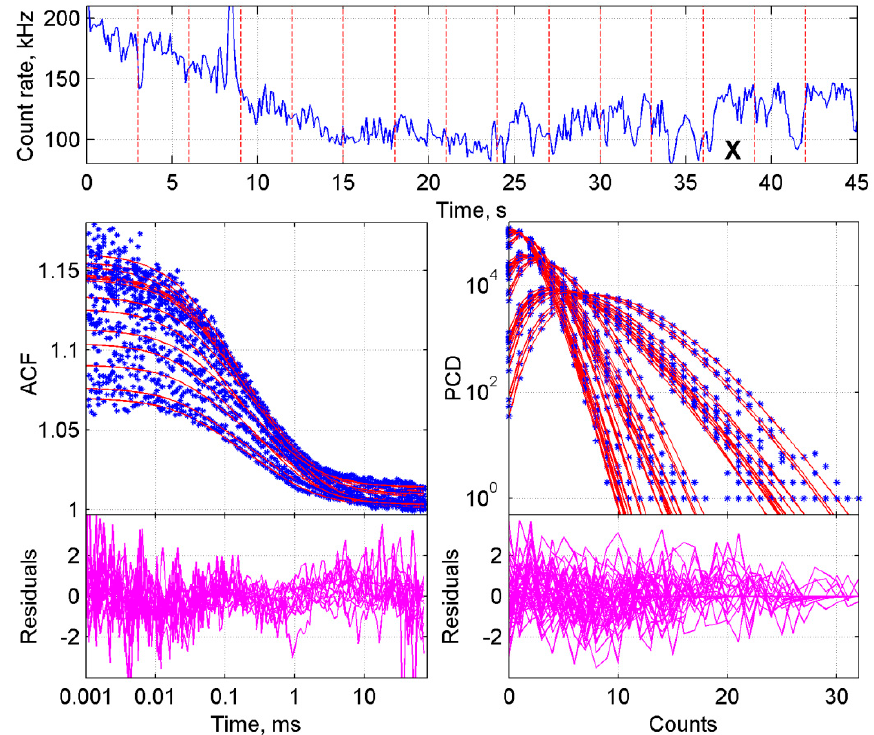
Figure 3. BDGA analysis of the ACF and PCD curves from GFP in living cells. The sample consisted of cells expressing GFP. Panels are explained in Figure 1. The measurement was divided into fifteen 3-s traces. Traces marked with an ‘X’ have been deleted based on visual inspection of the ACF curves. In the first 15 s, bleaching is taking place. The slight wave in the ACF residuals is expected because of internal movement of cellular compartments and fixation of the triplet state parameters. PCD curves were generated with three different time steps of 1 × 10 − 5 , 2 × 10 − 5 , and 5 × 10 − 5 s, respec-